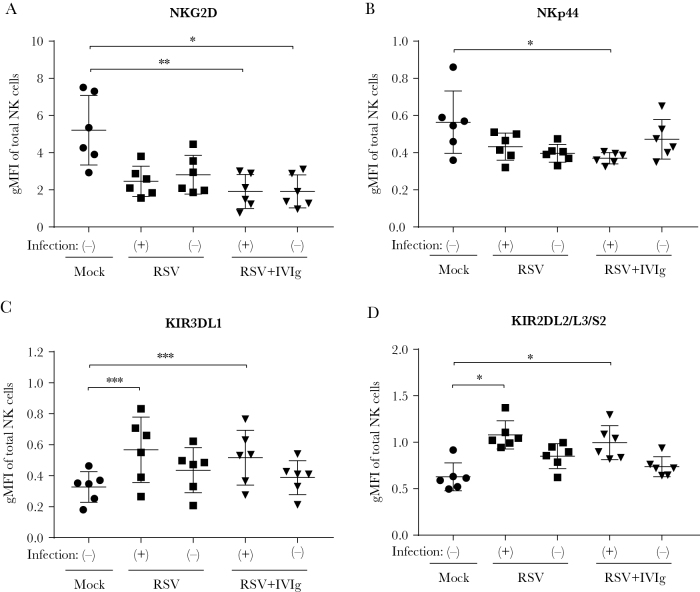
Phenotypic characterization of respiratory syncytial virus (RSV)–infected natural killer (NK) cells. A–C, Adult primary NK cells were inoculated with RSV-X or subneutralizing RSV-X antibody complexes (5 µg/mL intravenous immunoglobulin) and stained with 3 different antibody panels for flow cytometric analysis at 20 hours postinfection. RSV-infected and uninfected populations within 1 well are indicated with (+) and (-), respectively. Geometric mean of fluorescence intensity is depicted for the markers with the most pronounced differences compared to mock-infected NK cells: activating receptors NKG2D (A) and NKp44 (B), and KIRs KIR3DL1 (C), which is inhibitory, and KIR2DL2/L3/S2 (D), which can be either activating or inhibiting. Graphs depict the geometric mean and standard deviation of 6 donors pooled from 2 independent experiments. Nonparametric Friedman test with Dunn multiple comparisons test was used for comparison between multiple conditions (*P < .05, **P < .01, ***P < .001). Abbreviations: gMFI, geometric mean fluorescence intensity; IVIg, intravenous immunoglobulin; KIR, killer cell immunoglobulin-like receptor; NK, natural killer; RSV, respiratory syncytial virus.